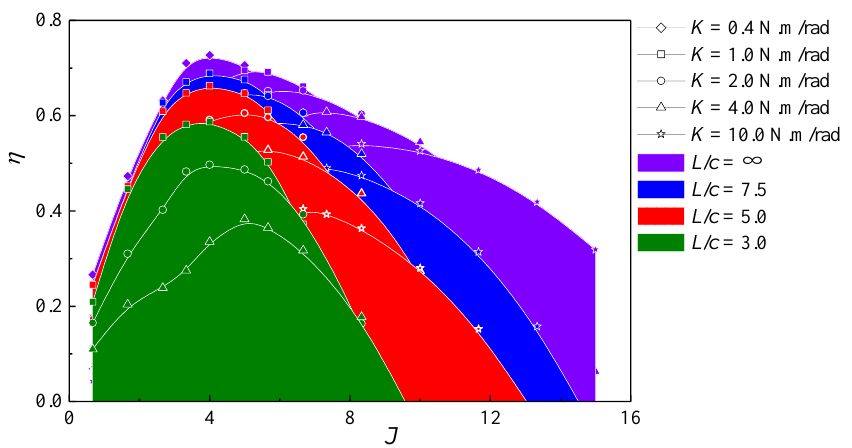
Figure 7. Propulsion efficiency curves with different arm length and different spring stiffness.